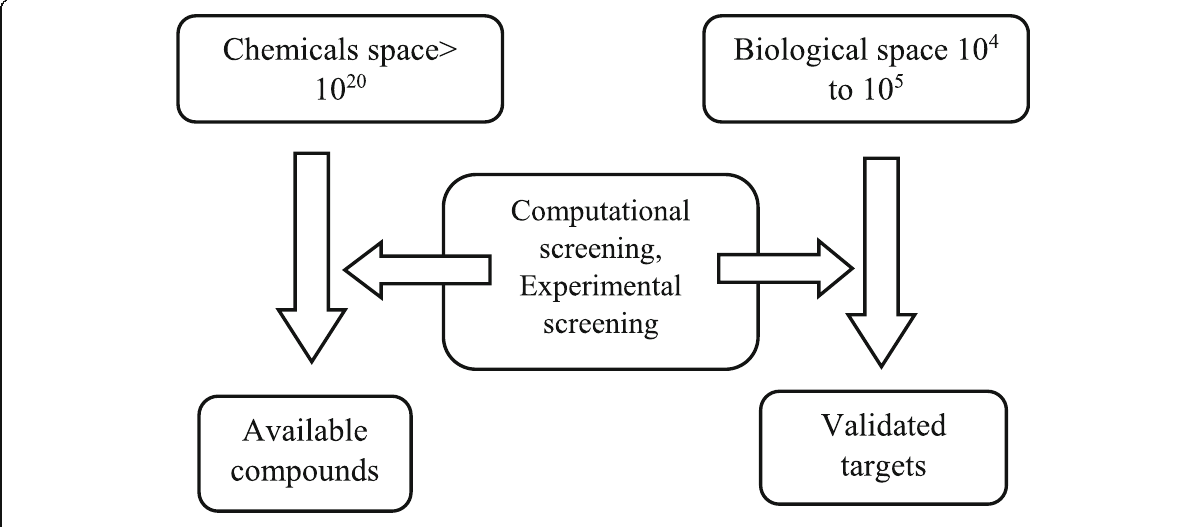
Fig. 8 Role of biological – chemical space in drug target validation